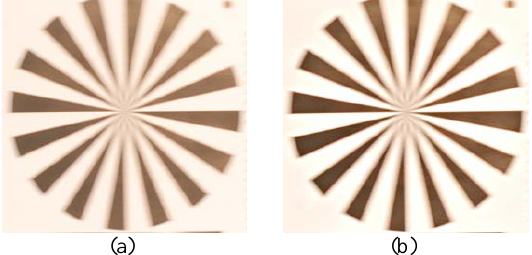
Figure 4. Figure (a) shows the blurred image before enhancement. (b) represents image (a) after enhancement. The image appears with stronger contrast but not